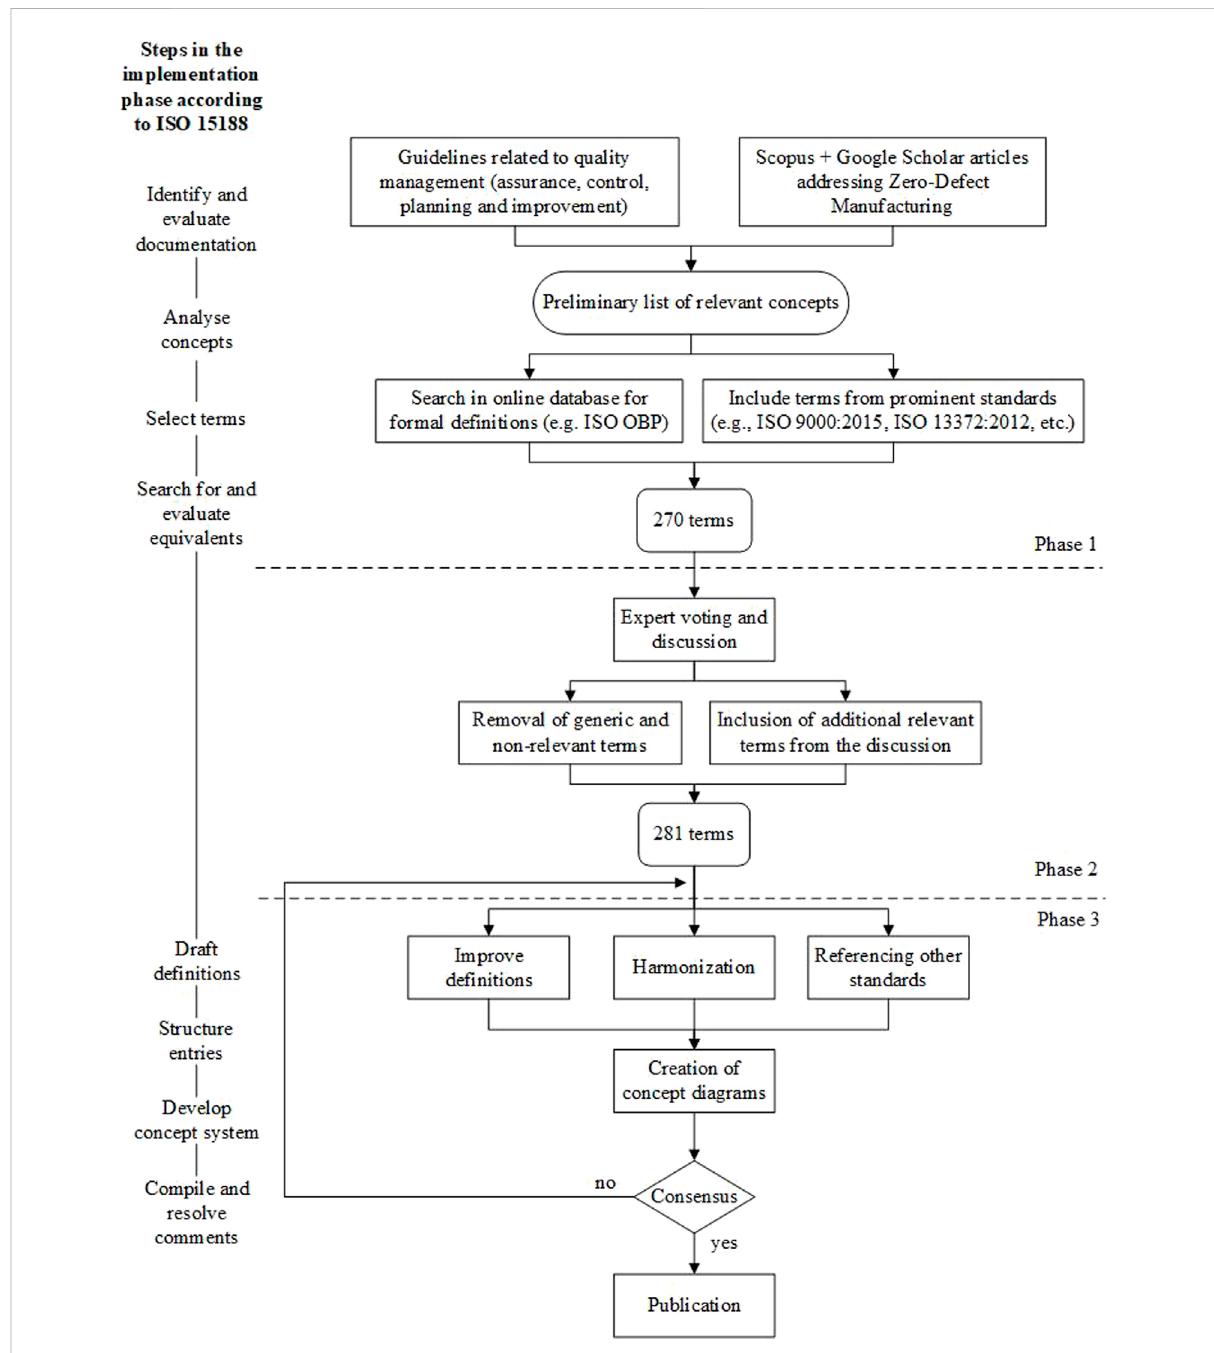
FIGURE 2 Adopted methodology in the ZDM Workshop for the creation of the ZDM